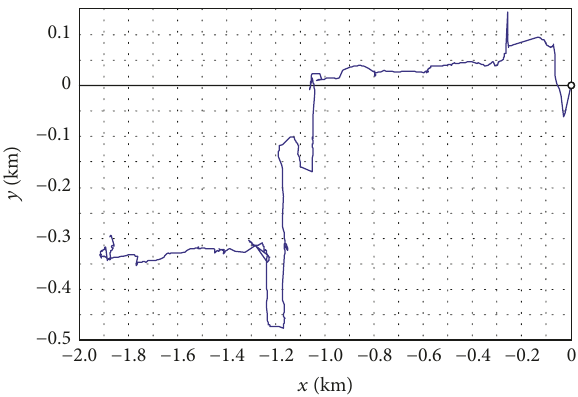
Figure 3: Effect of the 𝑘 -step-lag on the 𝑦 -RMSE of the UFIR filter, KF, and 𝐻 ∞ filter with different